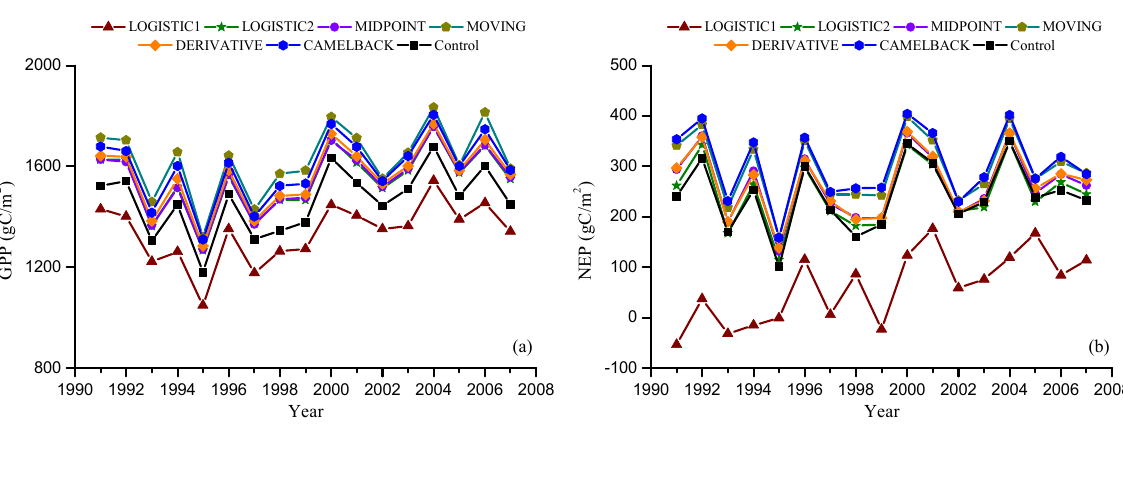
Figure 6. Simulated annual GPP and NEP from Dynamic Offset experiment. Leaf offset dates were simulated using the “Delpierre” model with the parameters optimized against remotely sensed offset using NDVI ( a , b ), and EVI ( c , d